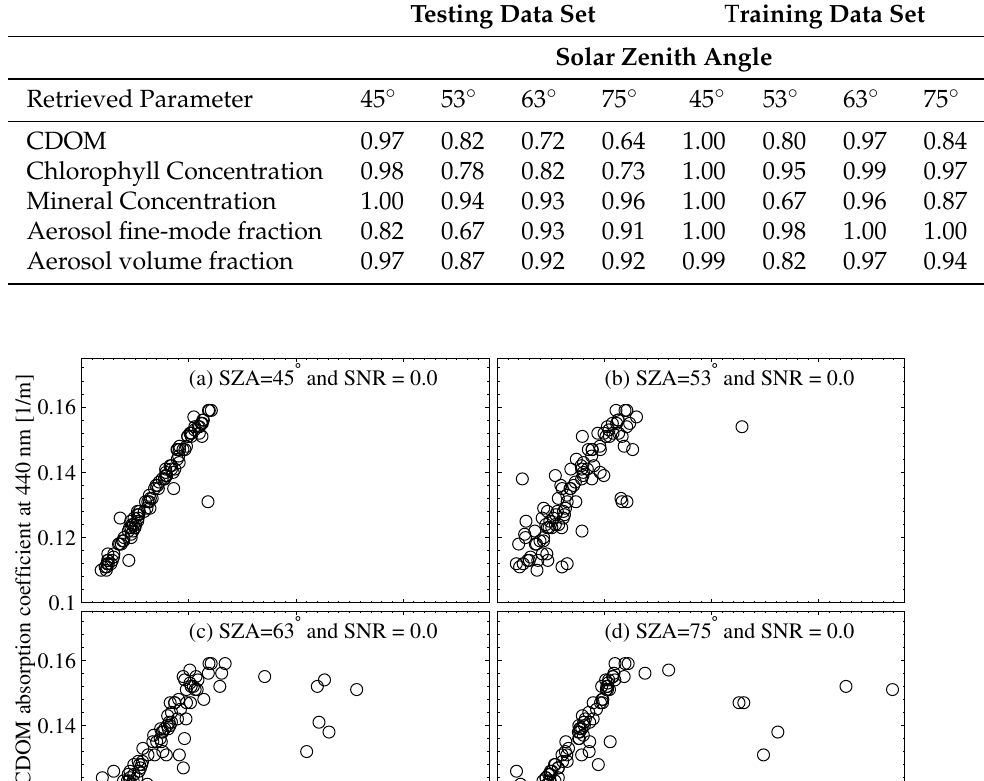
Table 2. Correlation coefficients between input parameters and retrieved parameters for different solar zenith angles in absence of noise.